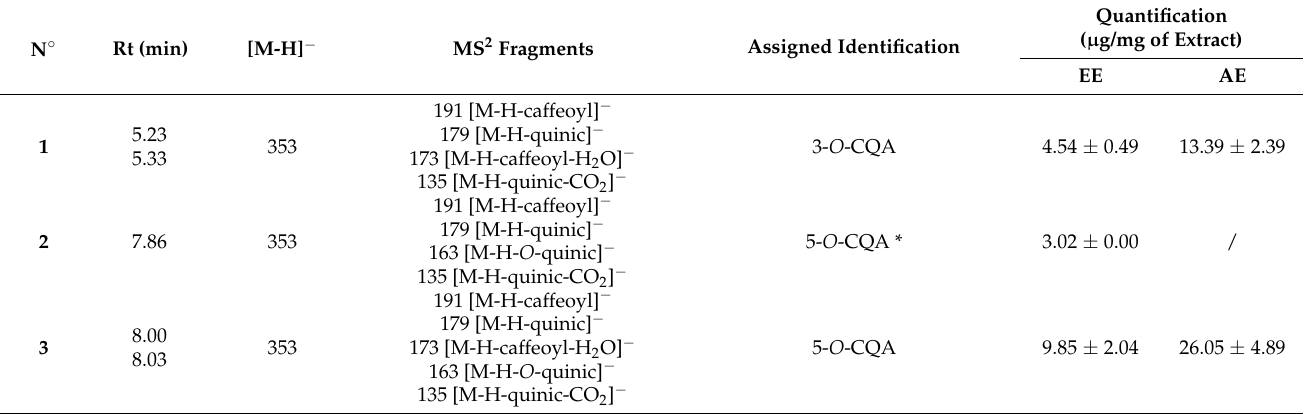
Quantification ( µ g/mg of